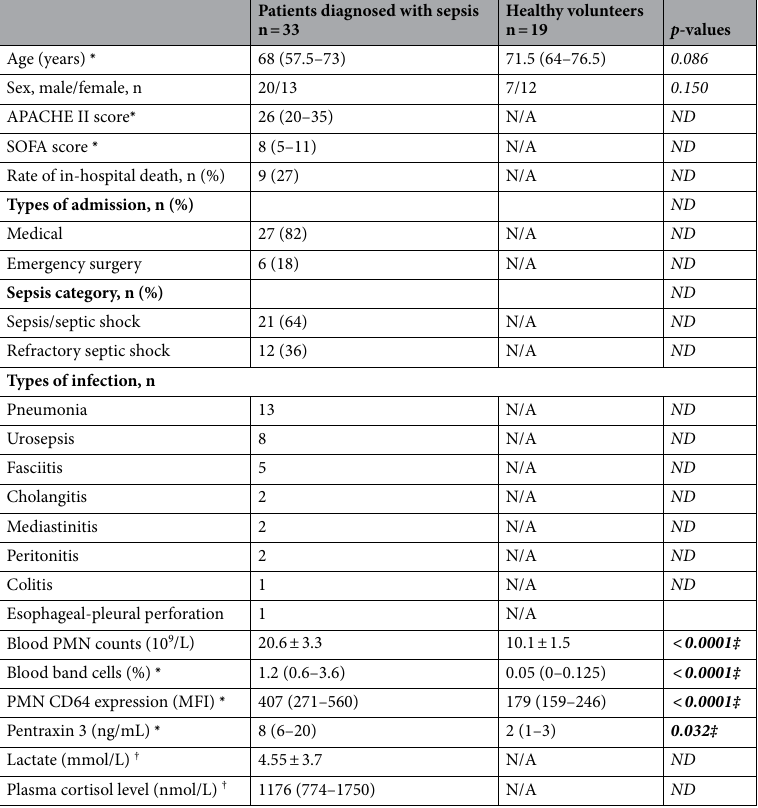
Table 2. General characteristics of the subjects enrolled in the study cohort. Data are expressed as the median [25–75 interquartile range] or mean ± SD † , as appropriate. The Mann–Whitney U test was used to compare age, and Fisher’s exact test was used for contingency in sex-based comparisons. Biological data were analyzed by Student’s t -test or the Mann–Whitney U test. There were four, five and two missing data points for CD64, PTX3, and cortisol measurements, respectively. N/A not applicable, ND not determined, APACHE II Admission Acute Physiology and Chronic Health Evaluation II, SOFA Sequential Organ Failure Assessment, PMN polymorphonuclear neutrophil, MFI mean fluorescence